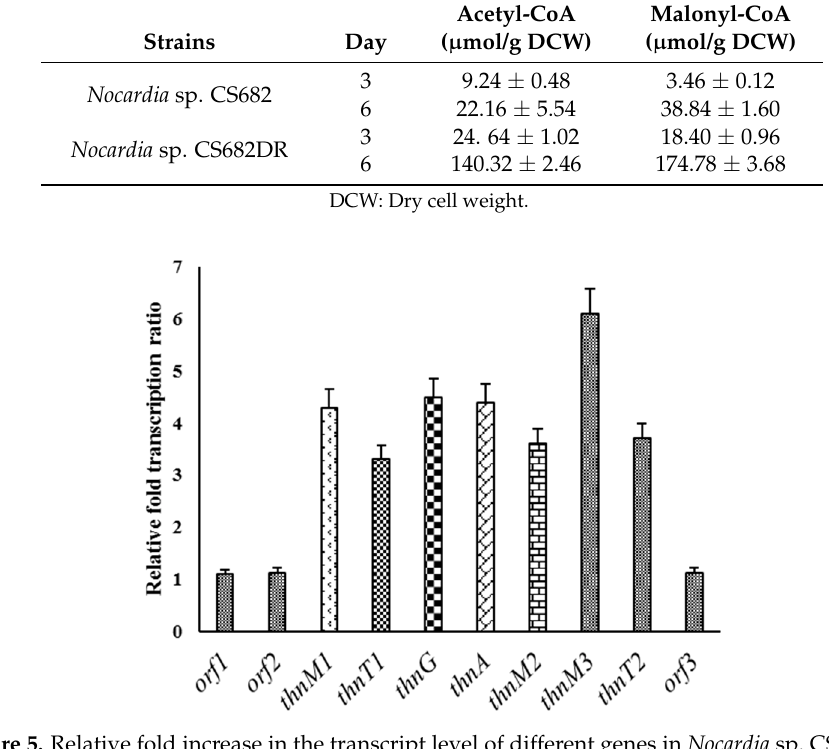
Figure 5. Relative fold increase in the transcript level of different genes in Nocardia sp.